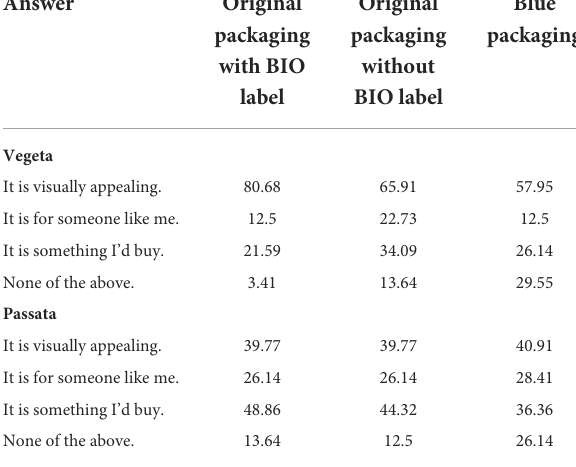
TABLE 4 Participants answers in percentage to the survey questions assessing conscious